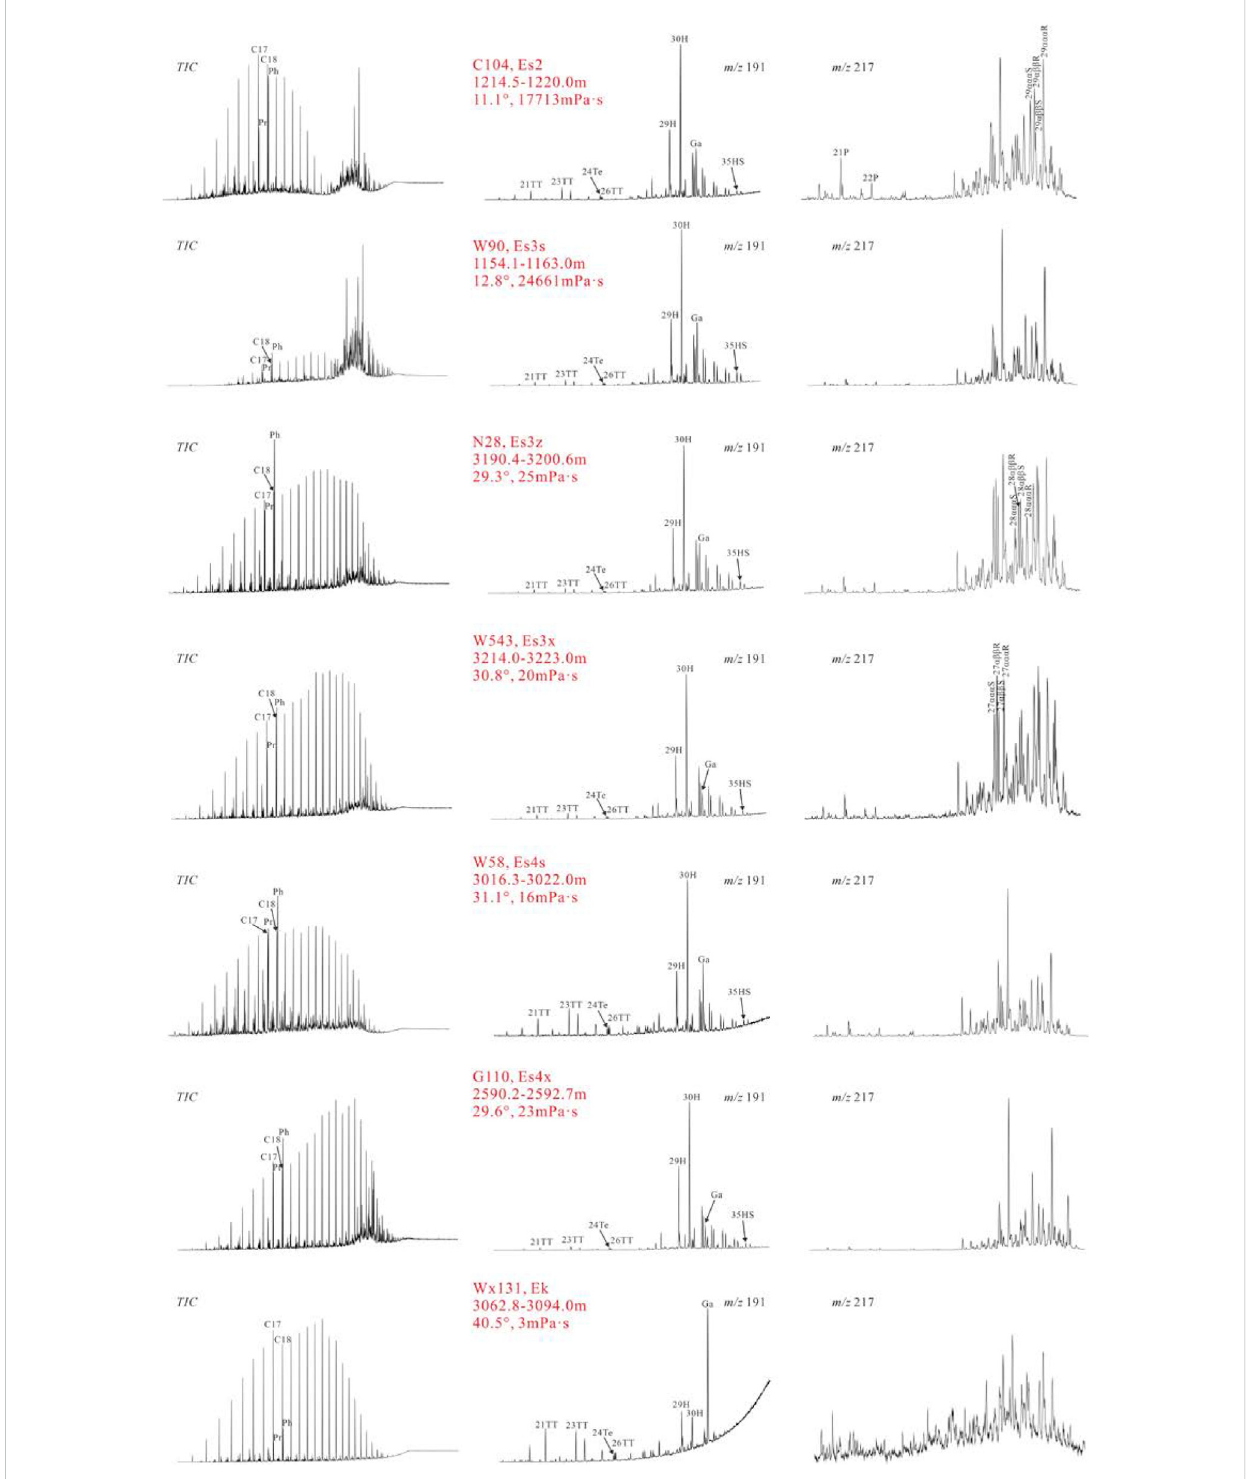
FIGURE 6 Representativegaschromatograms, m/z 191and217masschromatogramsfromoilsamplesshowingthedistributionofaliphaticfractions.Key:C17, C17 normal alkane; Pr, Pristane, Ph, Phytane; 21TT, C21 tricyclic terpane; 24Te, C24 tetracyclic terpane; 30H, C30 αβ hopane; Ga, Gammacerane; 35HS, C35 αβ 22S homohopane; 21P, C21 ααα pregnane; 22P, C22 ααα homopregnane; 27 ααα S, C27 ααα 20S